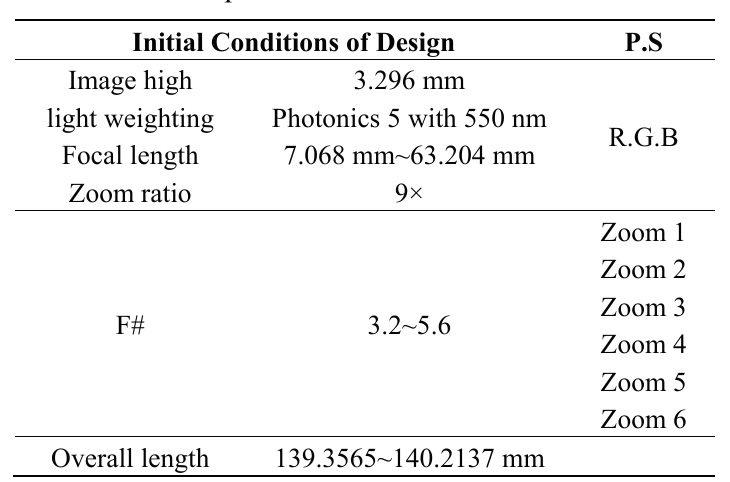
Table 1. Specifications of the 9× zoom lens.